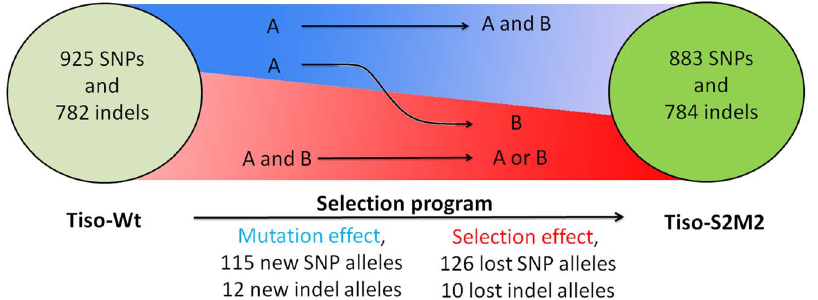
Figure 3. Impact of the selection program on the Tiso transcriptome. This figure is a schematic representation of the selection program. The number in each circle represents genetic diversity for each strain. Between these circles, evolutionary origins of polymorphisms between strains are illustrated: in red, polymorphism generated by loss of alleles (selection events), the narrower of area represent a reduction of diversity; in blue, new alleles (mutation events) the top of the area represents an increase of diversity; the arrow from blue to red, new and selected alleles (mutation and selection events).